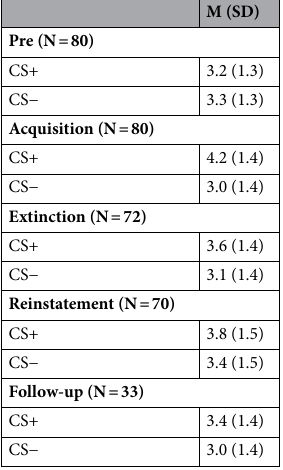
Table 1. Descriptive statistics for negative affective ratings presented separately for each stimulus and